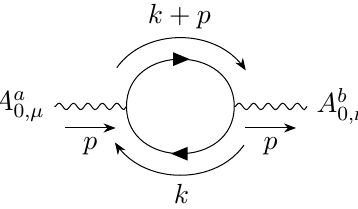
Figure 3. The diagram contributing to the Chern-Simons A ∧ F